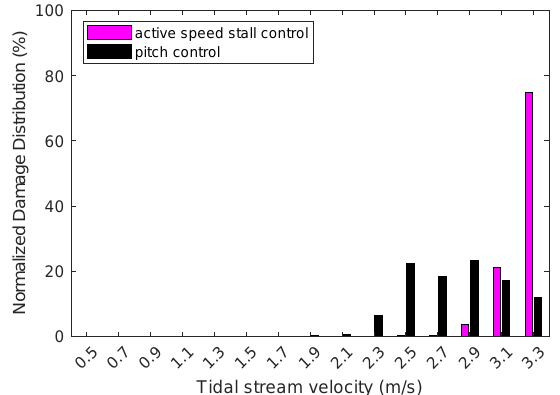
Figure 28. Damage distribution in active stall-controlled and pitch-controlled turbines (each normal- ized to 100%). Overall IGBT lifetime in the pitch-controlled turbine is much higher than in the active stall-controlled turbine. Whereas the lifetime consumption is concentrated at higher tidal velocities in the active stall-controlled turbine, it is more distributed in the pitch-controlled